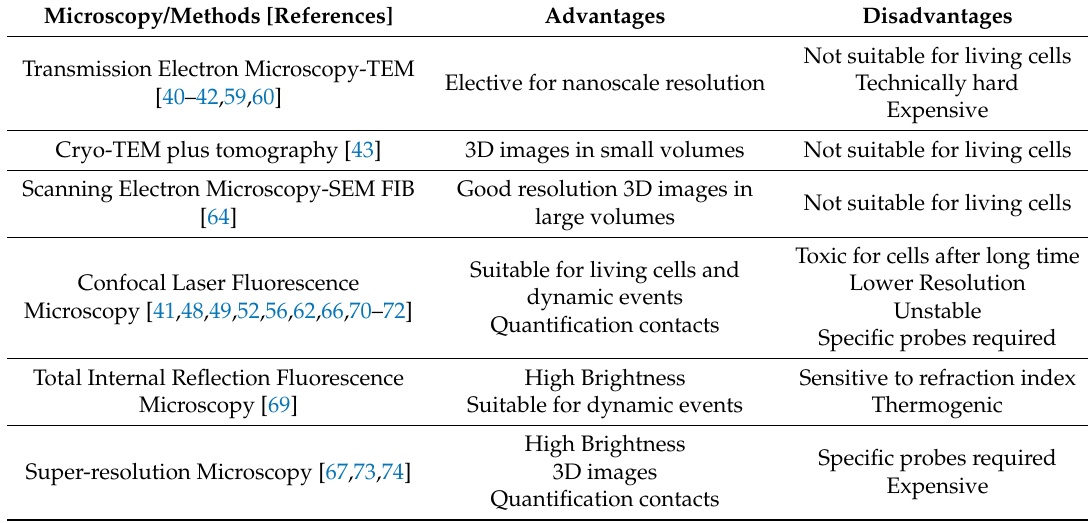
Table 1. MAMs/mitochondria-ER contacts (MERCs)/membrane contact sites (MCSs) imaging in cells. Microscopy/Methods [References] Advantages